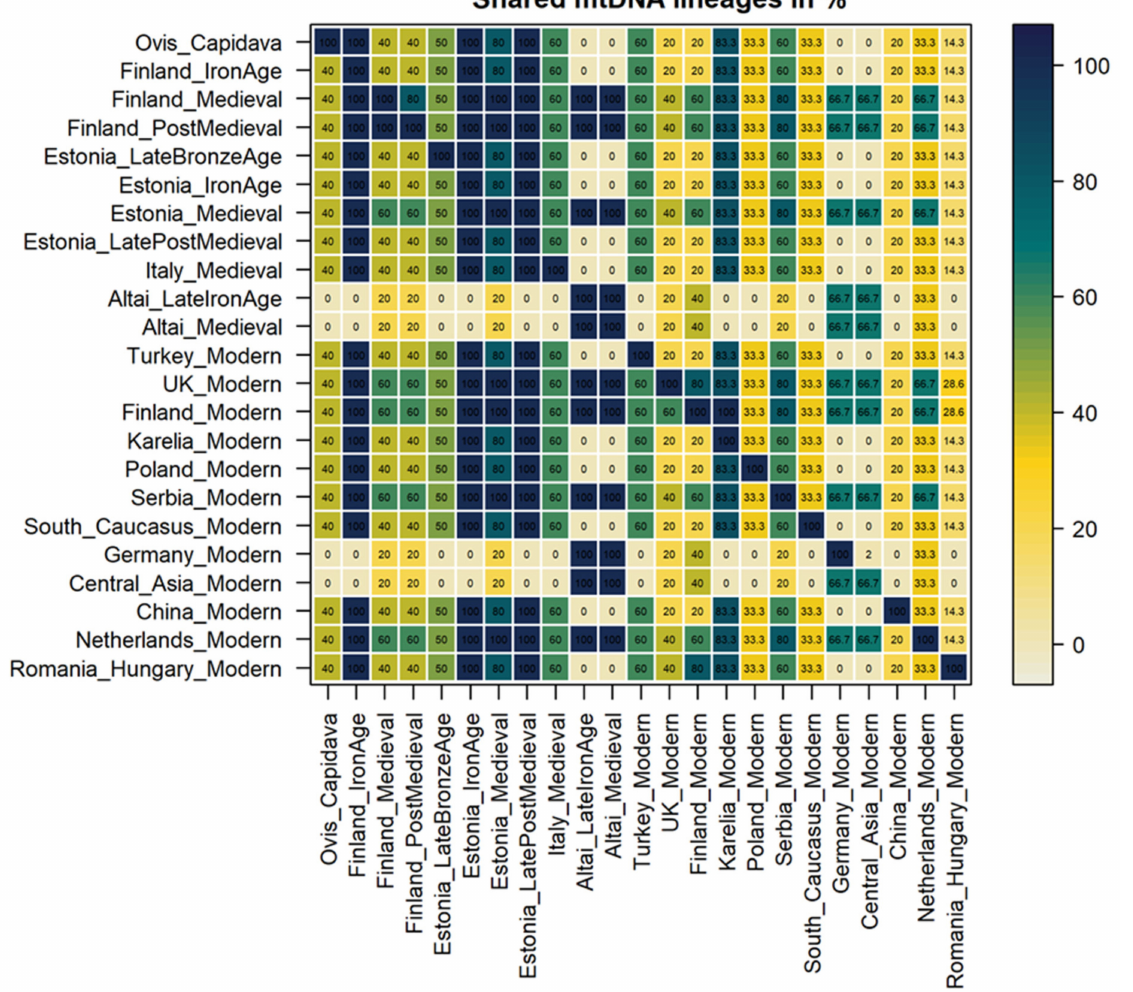
Figure 6. Heatmap of shared haplotype analysis between the Capidava population and 88 ancient and modern sequences grouped according to country of origin and historical period, based on the relative (%) number of shared haplotypes. The analysis was performed on a 304 bp region, nucleotide positions 16092 to 16396